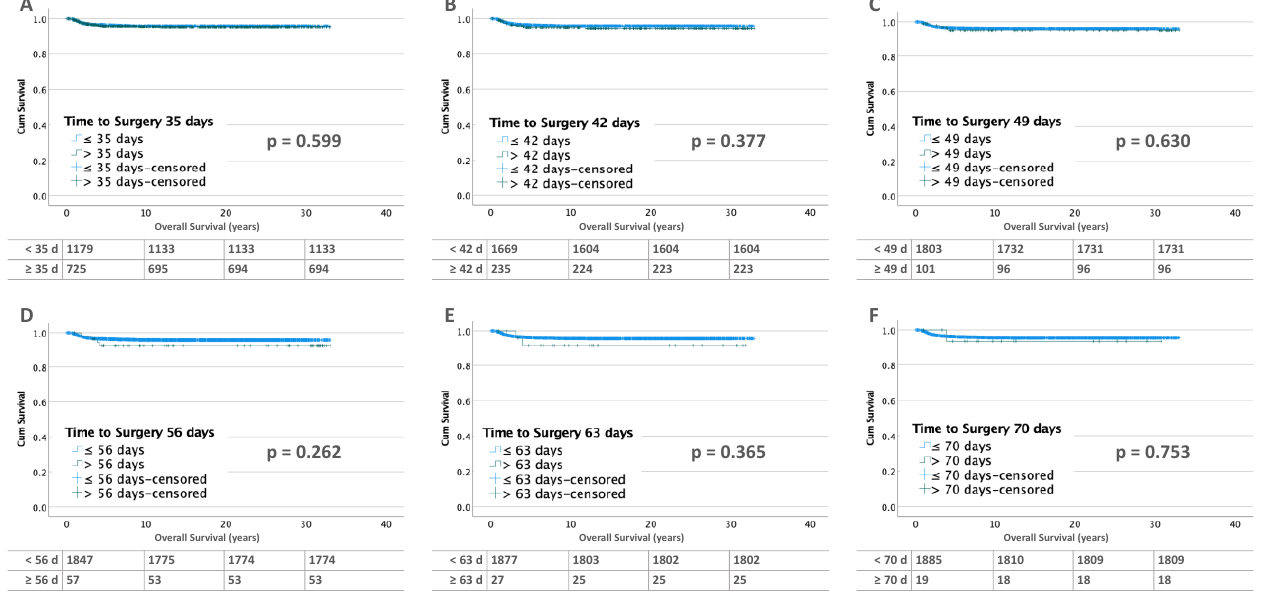
Figure 6. Kaplan–Meier lifetables of OS of unilateral WT without metastases at diagnosis at thresholds of 35 ( A ), 42 ( B ), 49 ( C ), 56 ( D ), 63 ( E ) and 70 ( F ) days of preoperative chemotherapy. In the tables below the figures, the numbers at risk are reported.